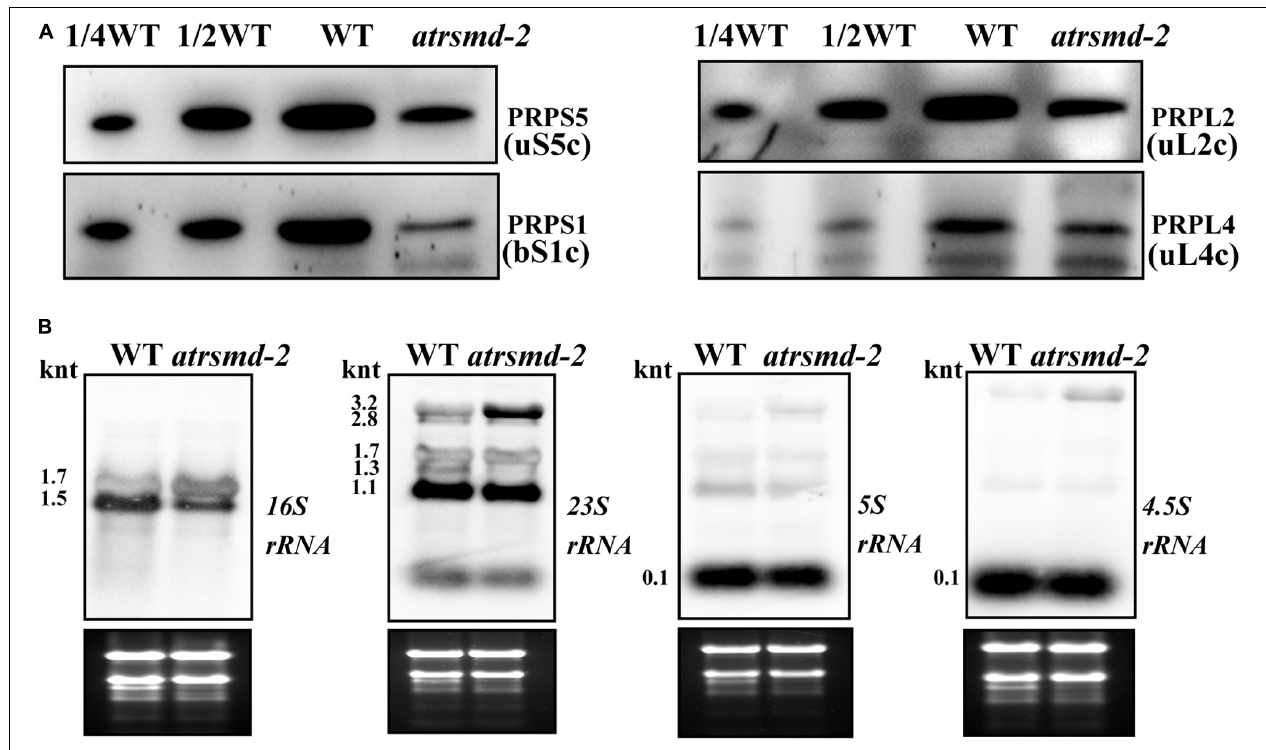
FIGURE 8 | Accumulation of chloroplast ribosomal proteins and chloroplast rRNAs in the wild type and atrsmd-2 mutant treated with cold stress. (A) Immunoblot analysis of chloroplast ribosomal proteins, including PRPS1/bS1c, PRPS5/uS5c, PRPL4/uL4c and PRPL2/uL2c, from the wild type (WT) and atrsmd-2 mutant treated with cold stress. Total proteins from the WT samples were loaded at three different concentrations (2.5, 5, and 10 µ g), and total proteins from the mutant samples were loaded at 10 µ g. (B) RNA gel analysis of chloroplast rRNA species in the wild type and atrsmd-2 mutant treated with cold stress. Total RNA (5 µ g) was loaded in each lane with the corresponding probes as shown